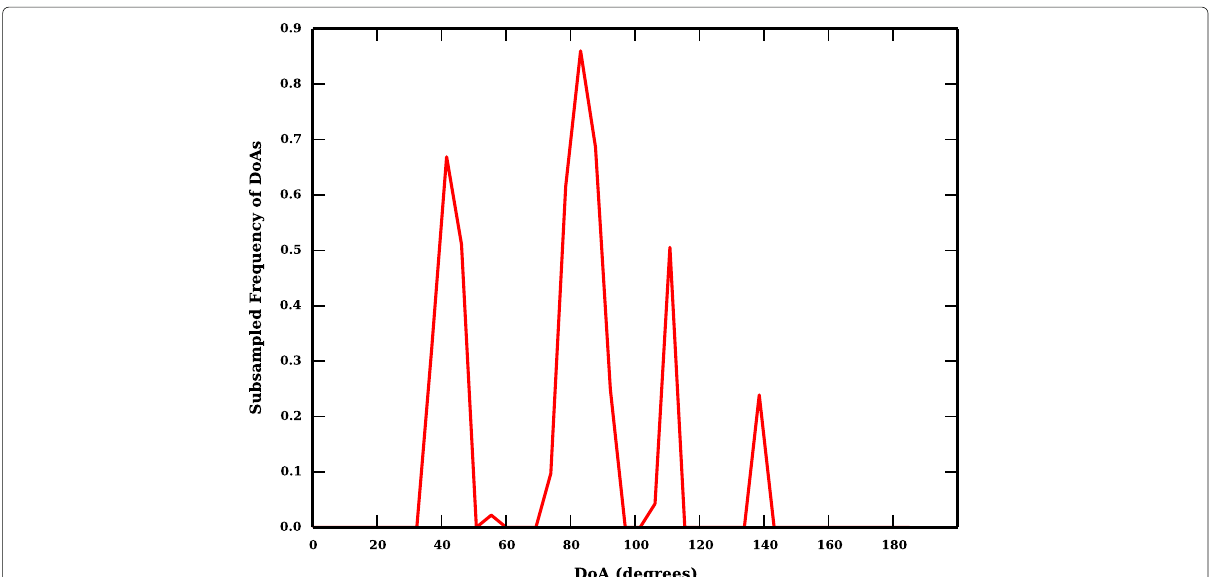
Fig. 12 Subsampled histogram of DoA estimates obtained by SRP-NMF on recording2 ( Task2 ) from LOCATA1 containing four concurrent